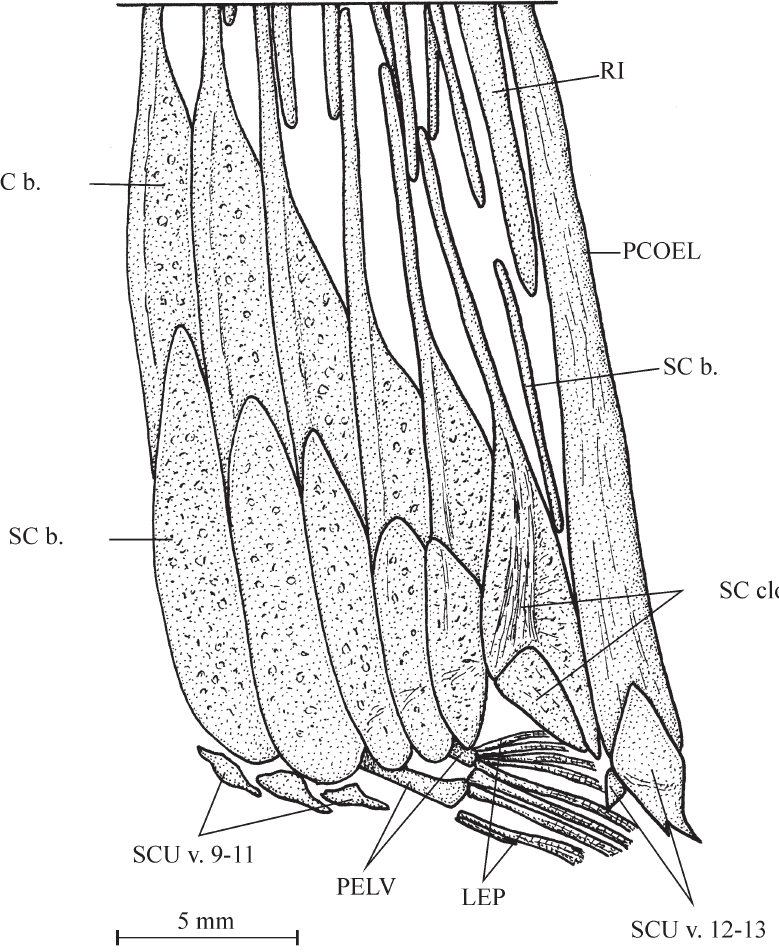
Fig. 19. Acrorhinichthys poyatoi gen. et sp. nov. Reconstruction of the pelvic girdle and the scales of the cloacal region based on the holotype CLC S-630a,